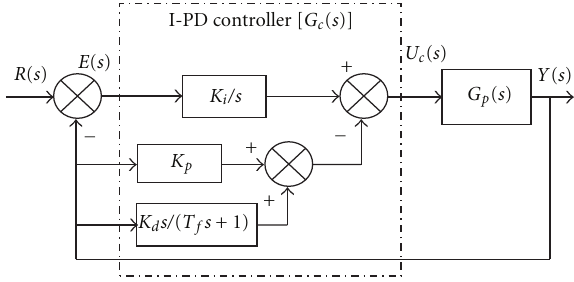
Figure 4: Structure of parallel I-PD control